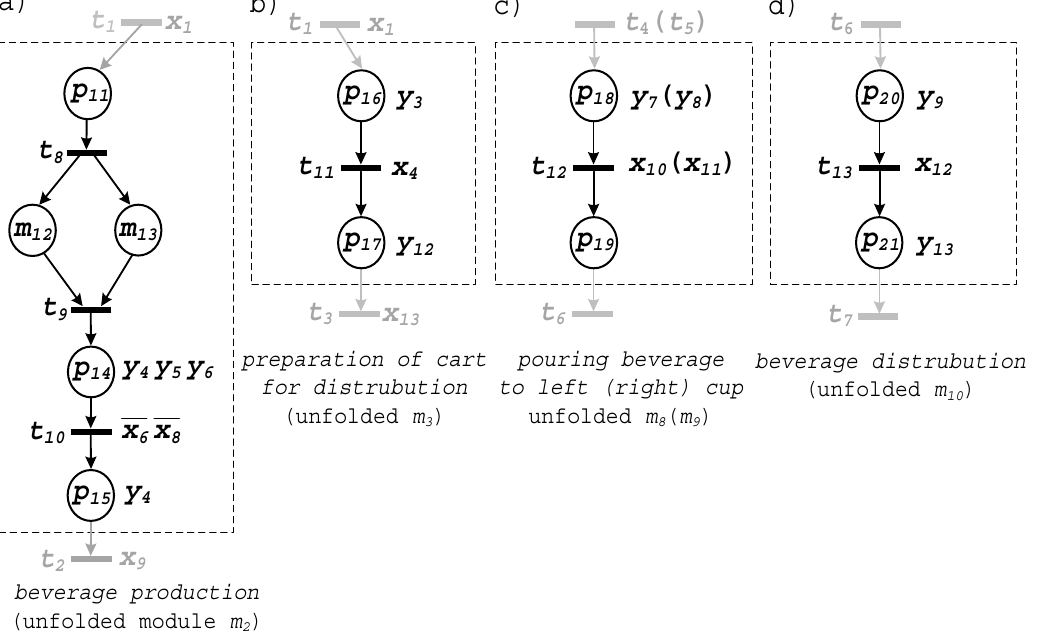
Figure 6. Unfolded top module (first “unfolding” level): ( a ) m 2 , ( b ) m 3 , ( c ) m 8 ( m 9 ), ( d ) m 10.